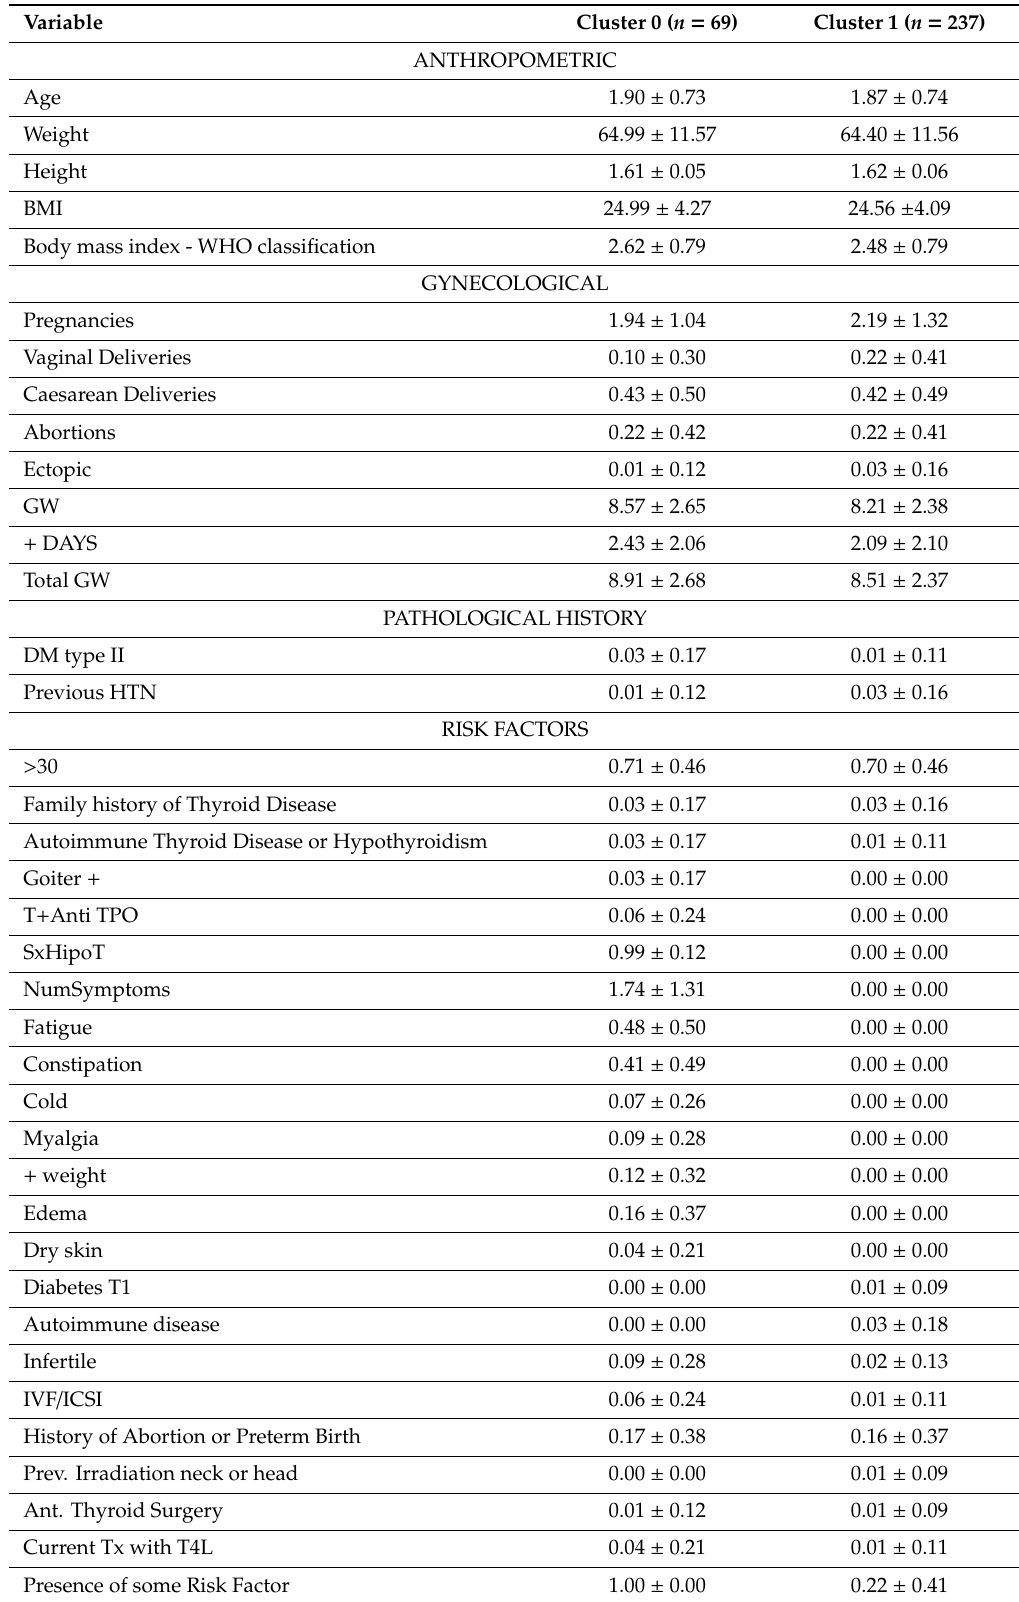
Table 3. Characteristics stratified by all features. Features are presented as mean ±